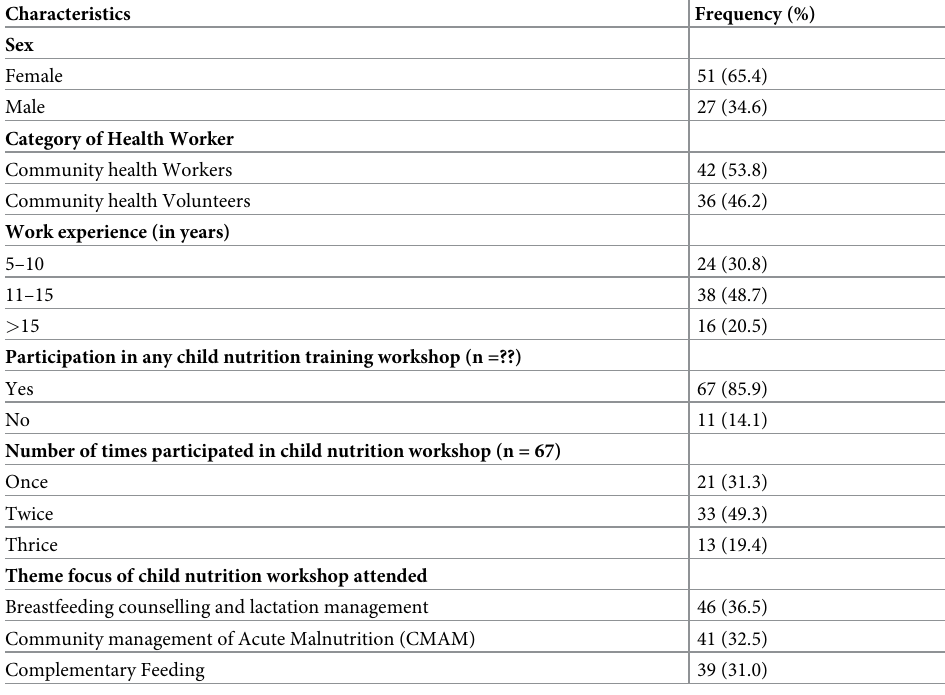
Table 1. Demographic information of study